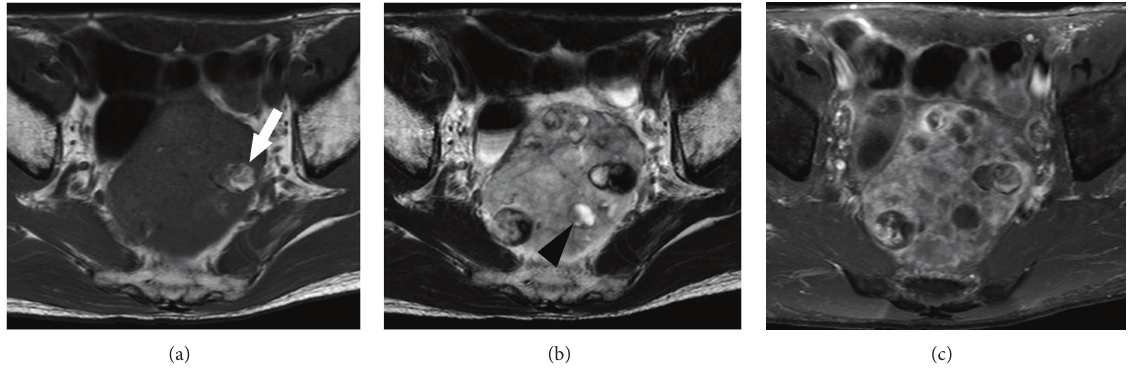
Figure 2: (a) T1-weighted MR image shows a well-defined hypointensity mass with focal high-intensity area (arrow). (b) T2-weighted image shows heterogeneous hyperintensity mass with spotty hyperintensity area (arrowhead). (c) Contrast-enhanced image shows slight enhancement in solid component of the